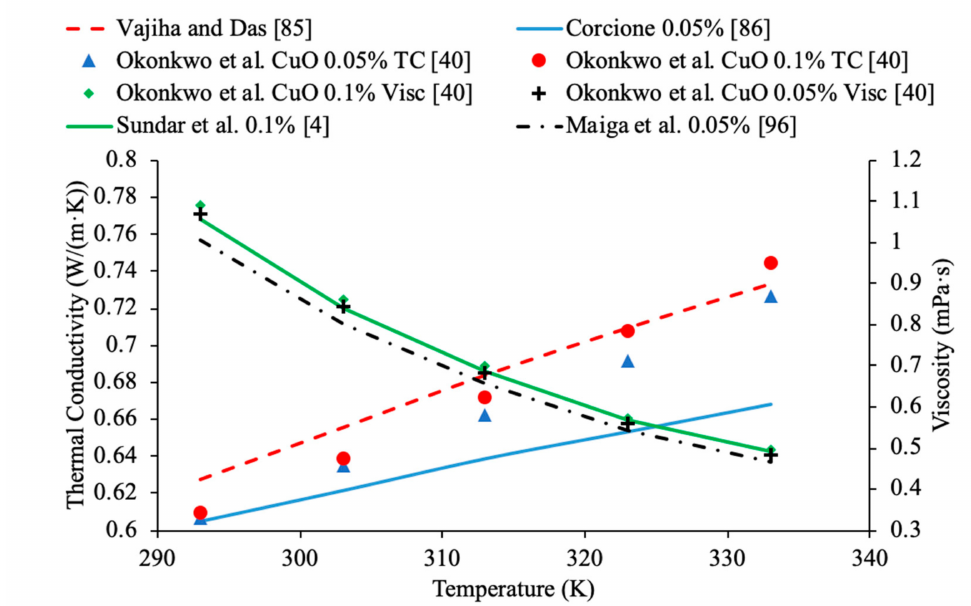
Figure 45. Thermal conductivity (increasing with temperature) and viscosity (decreasing with temperature) for CuO–water nanofluids at 0.1% and 0.05% [70] (40) concentrations in comparison to different theoretical models